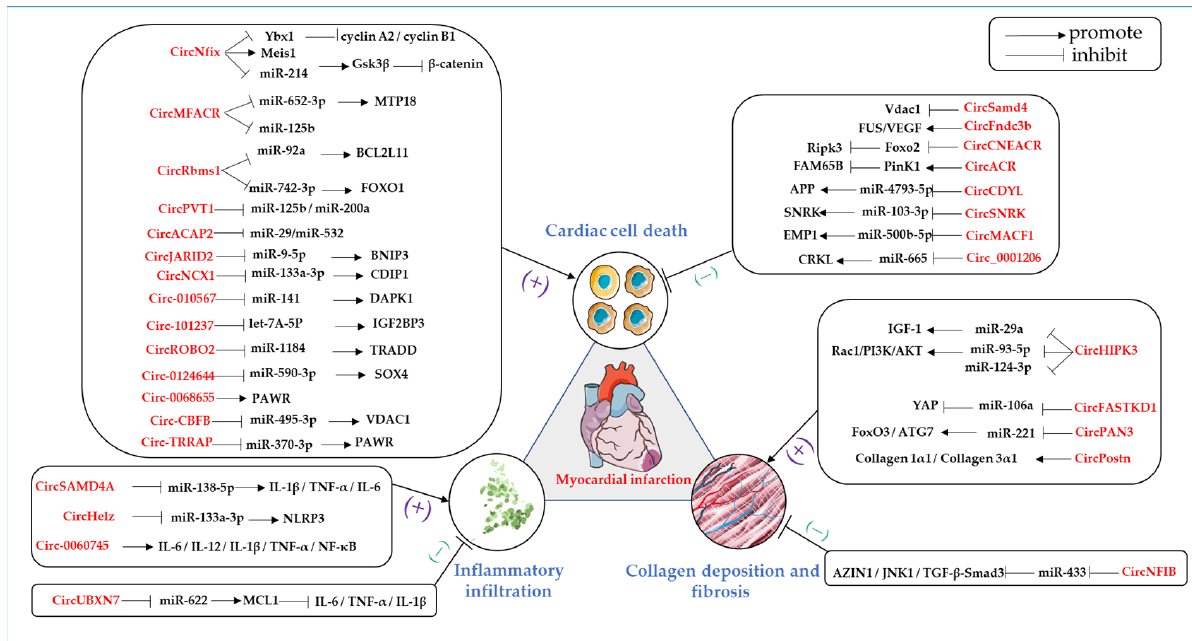
Figure 2. The role of circular RNAs in the pathogenesis of myocardial infarction, including cardiac cell death, inflammatory infiltration, and collagen deposition and fibrosis. All circular RNAs are labeled in red. They are described in detail in the text. The arrows in the figure represent the role of promotion. The T bars indicate the effect of inhibition [20,21,41,42,45–68,70–77].